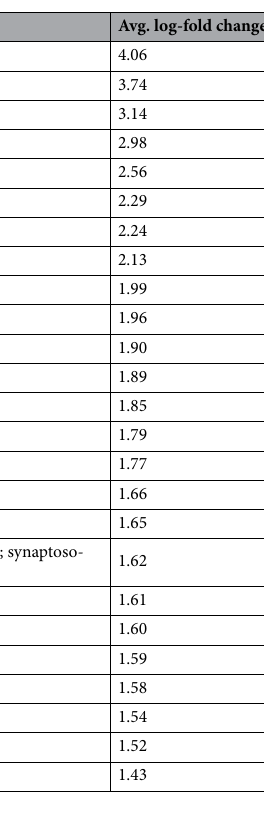
Table 2. The top 25 most abundant genes in the neuron cluster. Average log-fold change indicates higher expression over other cell types. The adjusted P-value for each gene was <